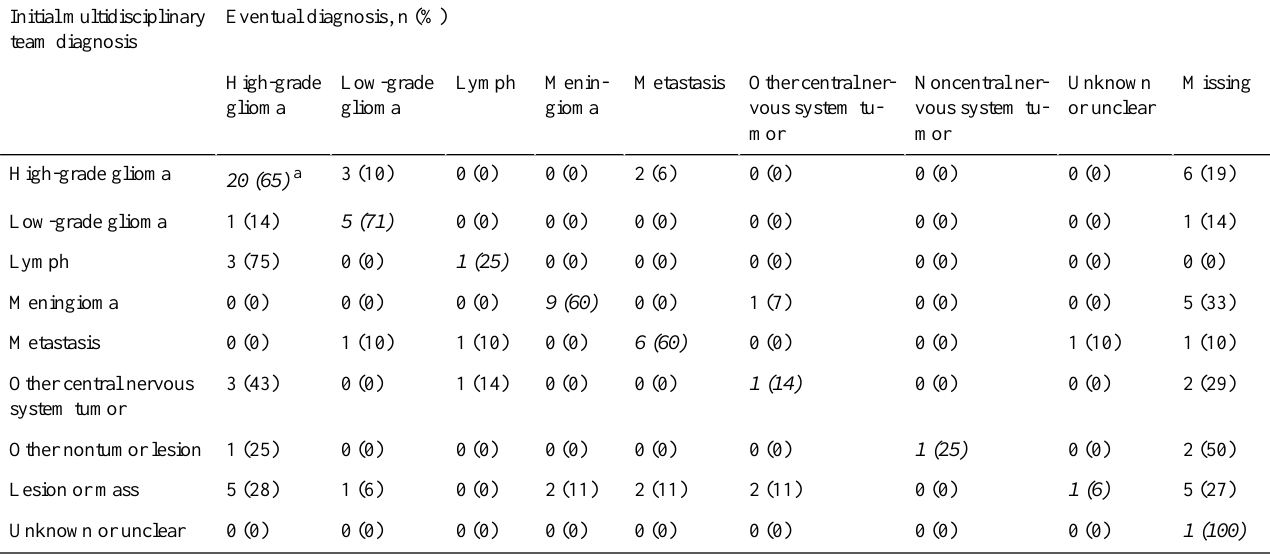
Table 2. Distribution (number and percentage) of eventual diagnostic groups after surgery in each initial multidisciplinary team meeting diagnostic group among patients who had surgery.